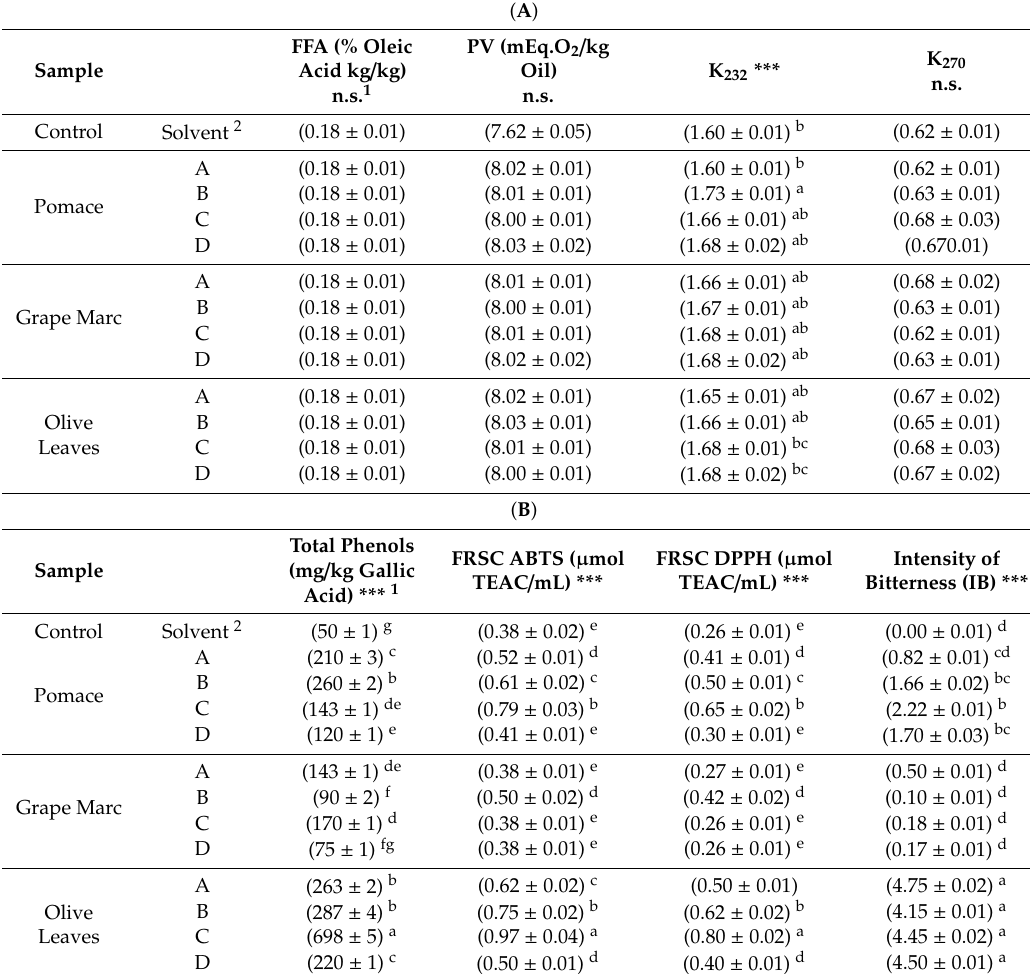
Table 3. ( A ) Chemical characterization (free fatty acids (FFA), peroxide value (PV), and spectrophotometric indexes (K 270 and K 232 )) of phenol-enriched ROOs; ( B ) phenolic content, antioxidant capacity, and intensity of bitterness of phenol-enriched ROOs. Each value represents mean ± standard deviation ( n =